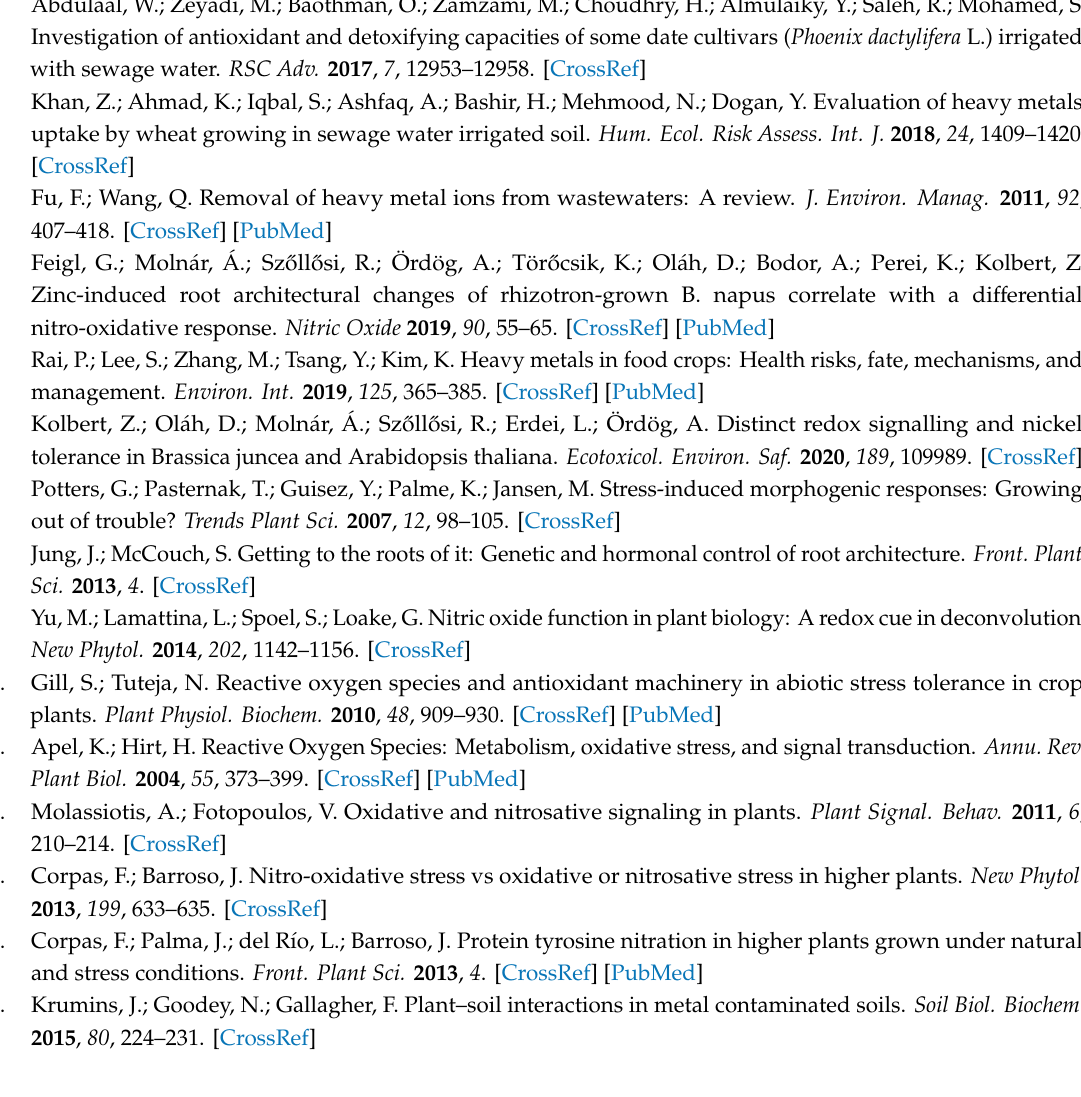
Table S1: Properties and e ff ects of cadmium, chromium, copper, lead, mercury, nickel, and zinc on plants., Figure S1: Schematic design of the rhizotron system applied (A) and growing B. napus seedlings in the rhizotrons filled with soil (B)., Figure S2: Callose (A) and pectin (C) content in the root tip of 10 day-old H. annuus and 6 day-old B. napus (B,D) grown in control soil or in soil di ff erently treated with combined heavy metals., Figure S3: Visualization of the changes in the angle of the lateral roots with the primary root., Figure: S4. Representative images of Schi ff staining in order to detect lipid peroxidation in sunflower (A) and rapeseed (B) root tips under control circumstances and submitted to di ff erent combined heavy metal